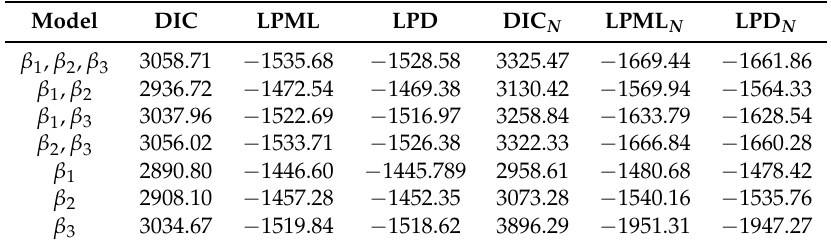
Table 2. Deviance information criterion (DIC) logarithm pseudo marginal likelihood (LPML), and log probability density (LPD) of candidate models.